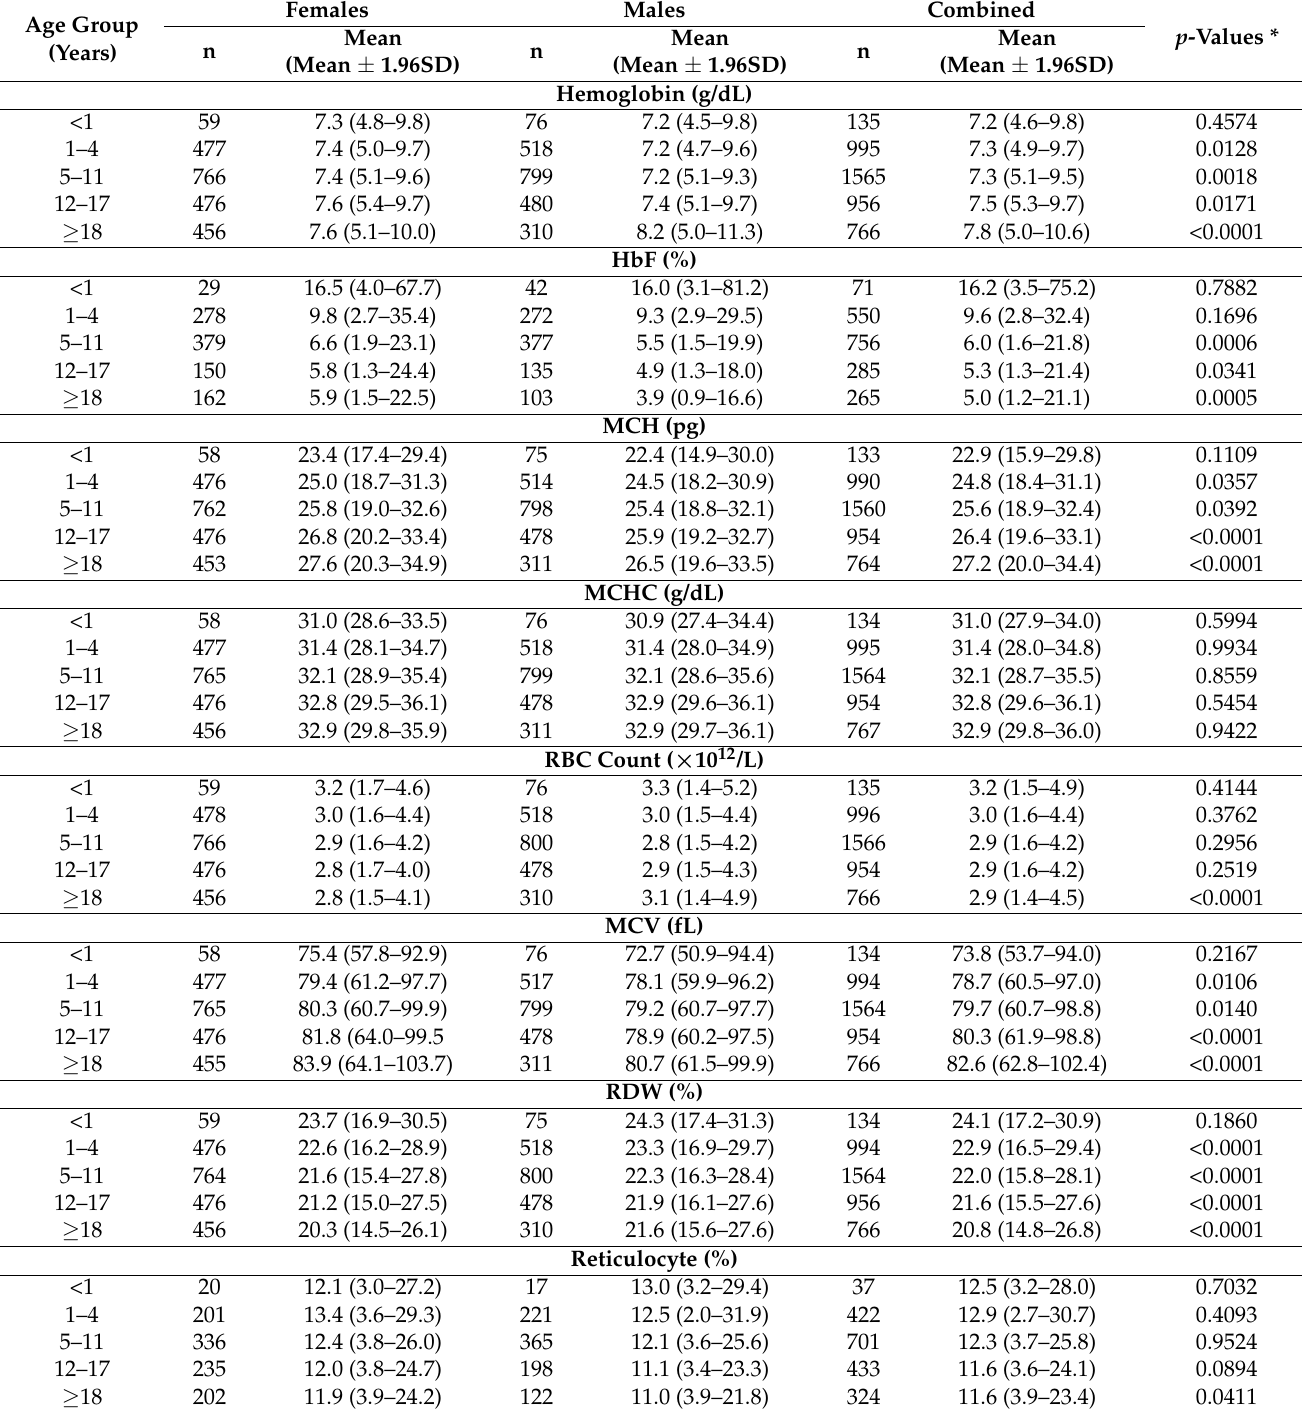
Table 2. Steady state hematological reference values calculated as mean (mean ± 1.96SD) in SCD, categorized by age groups and